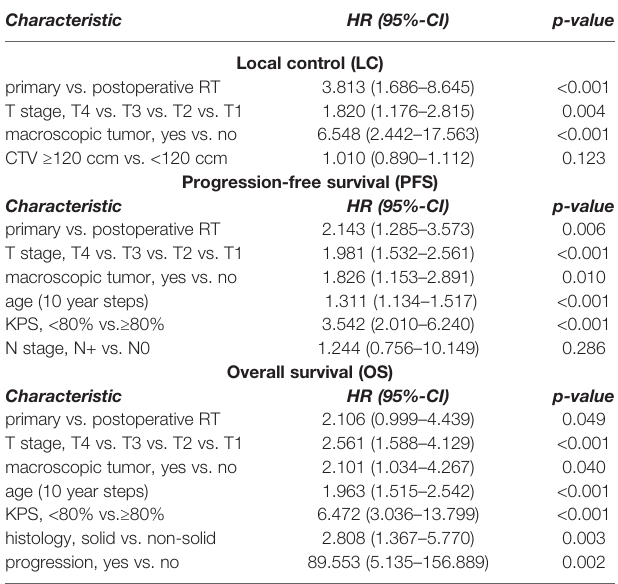
TABLE 2 | Results of multivariate analysis*.